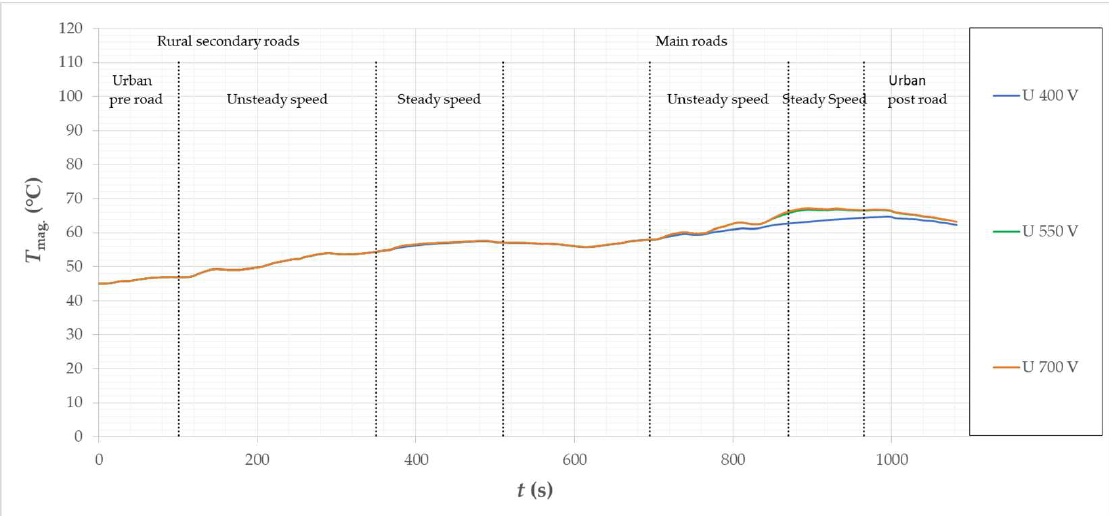
Figure 28. Calculated temperature waveforms in permanent magnets of the motor for the considered vehicle in the Artemis Road driving cycle.